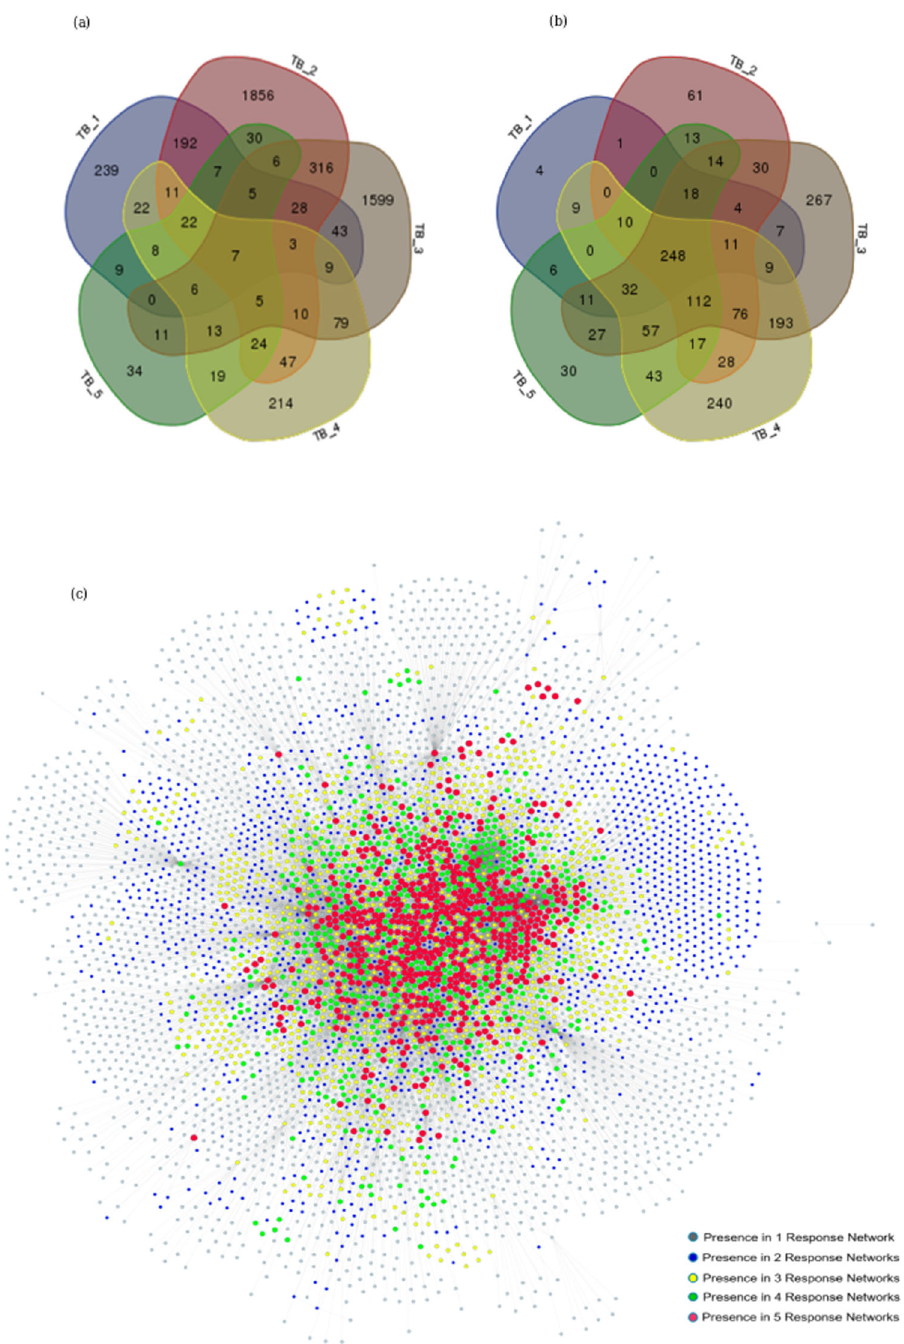
Fig. 2 Comparison of whole blood transcriptomic datasets in tuberculosis at different levels reveals commonalities among differences. a A Venn diagram illustrating very little overlap between DEGs reported by individual datasets b Comparison of gene ontology terms for the DEGs however, reveal several common enriched biological processes across datasets c Pooled representation of individual response networks generated for all fi ve datasets, illustrates a considerable amount of overlap. Node colours and sizes are proportional to the number of response networks the nodes occur in, with single occurrences seen at the periphery of the network ( grey ) and nodes occurring in all response networks ( red ) forming a highly interconnected core in the centre highlighting their high